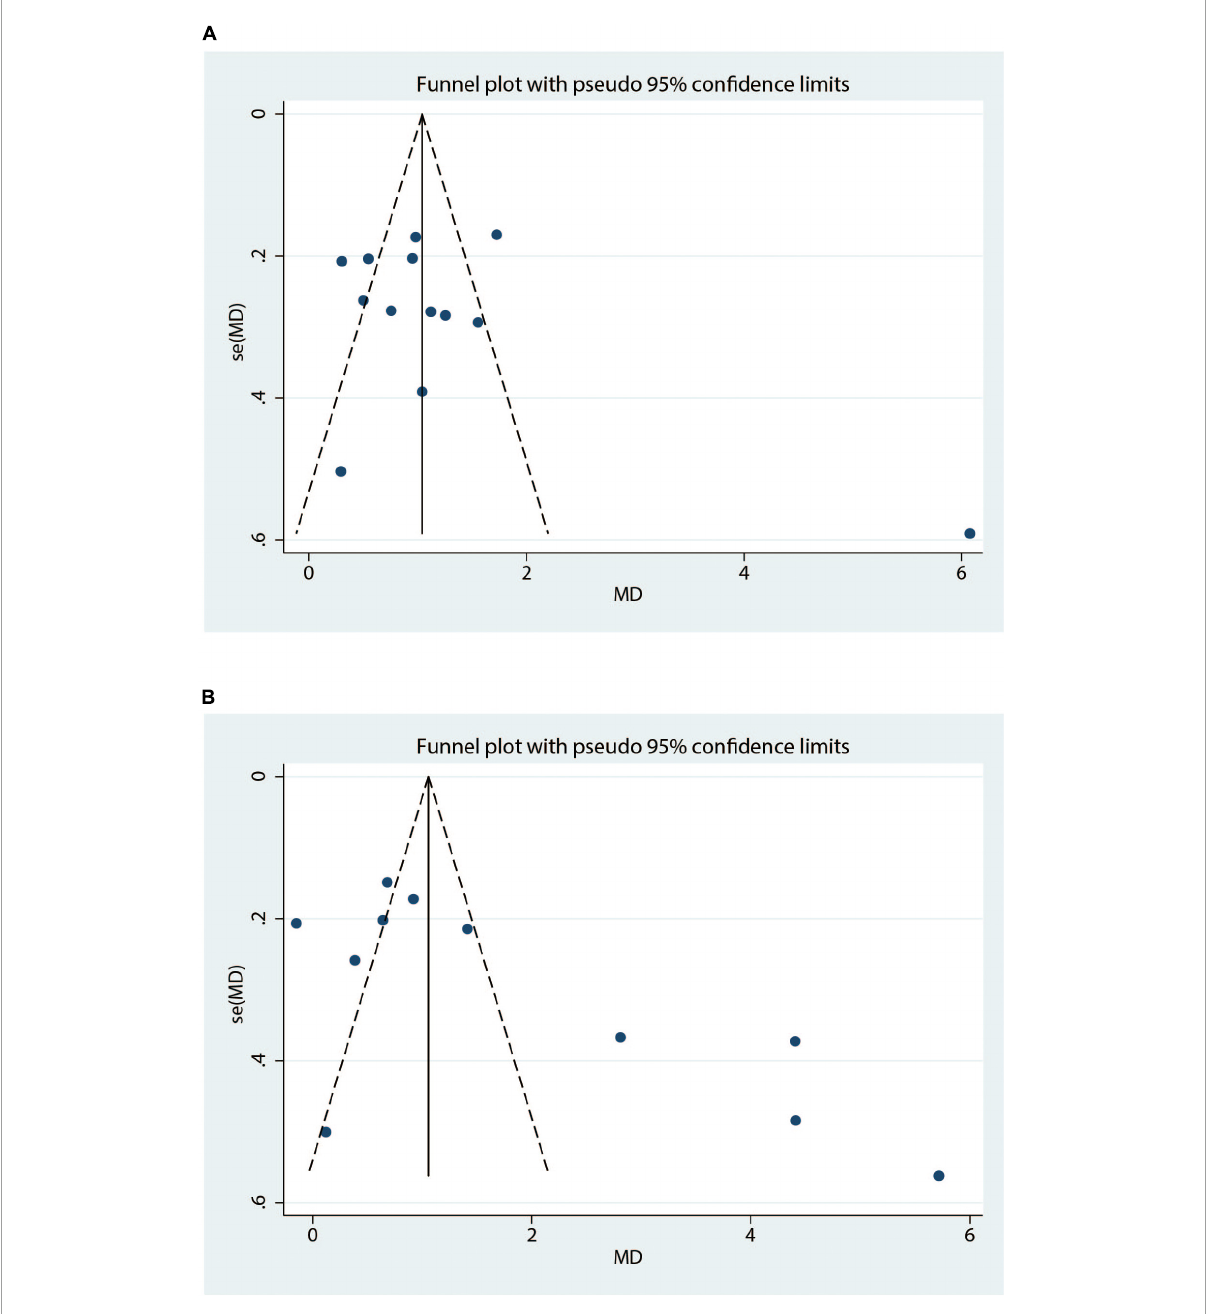
FIGURE12 Funnel plots of 6MWT (A) and LVEF (B) . MD, mean